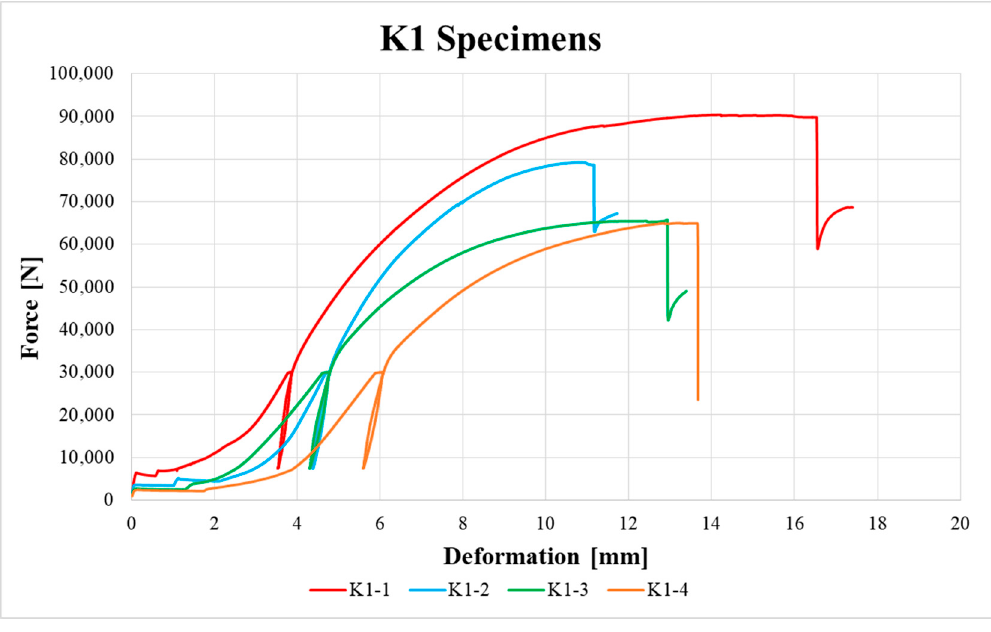
Materials 2020 , 13 , x FOR PEER REVIEW Figure 12. Load–deformation curves of K1 specimens. Figure 12. Load–deformation curves of K1 specimens.